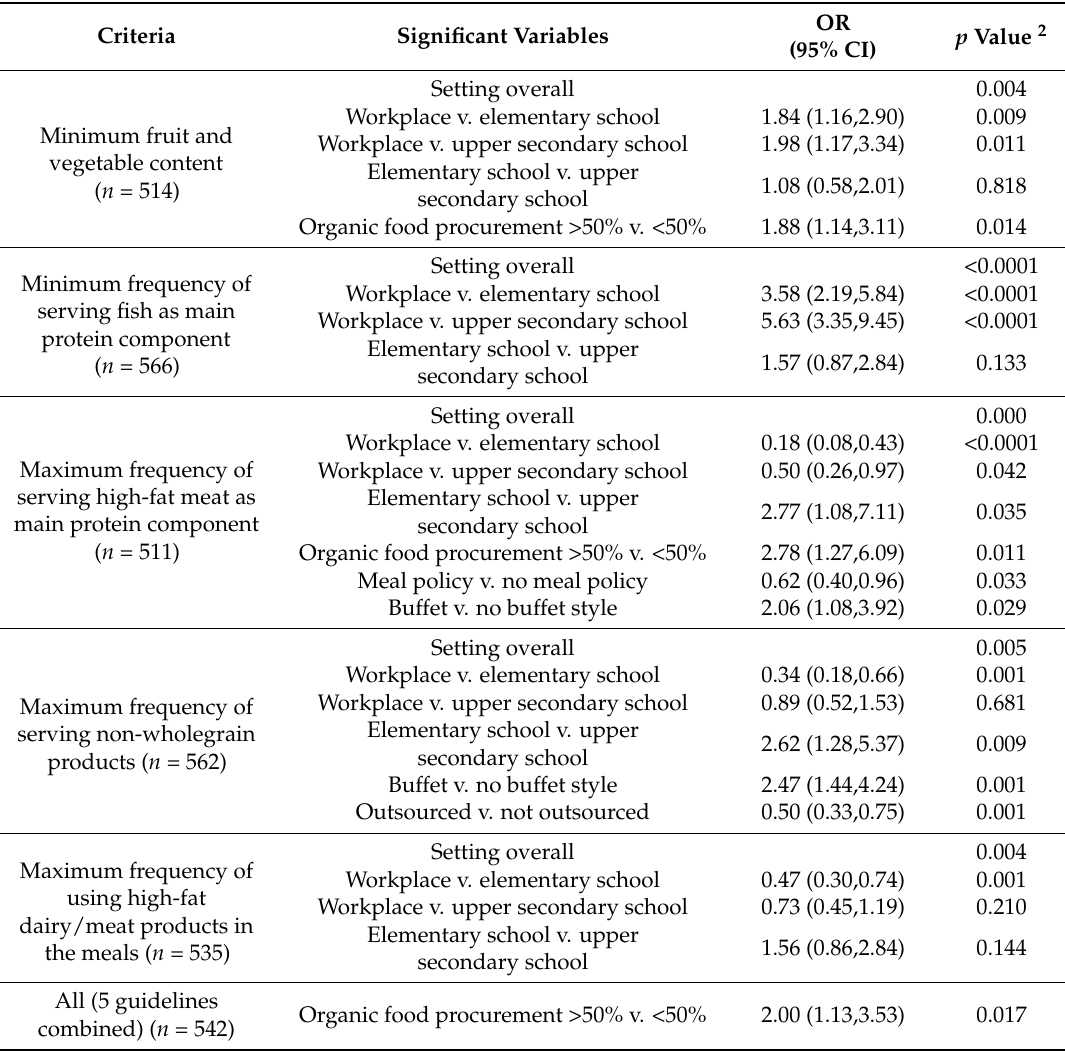
Table 4. Variables significantly ( P ≤ 0.05) associated with compliance with guidelines for hot meals 1